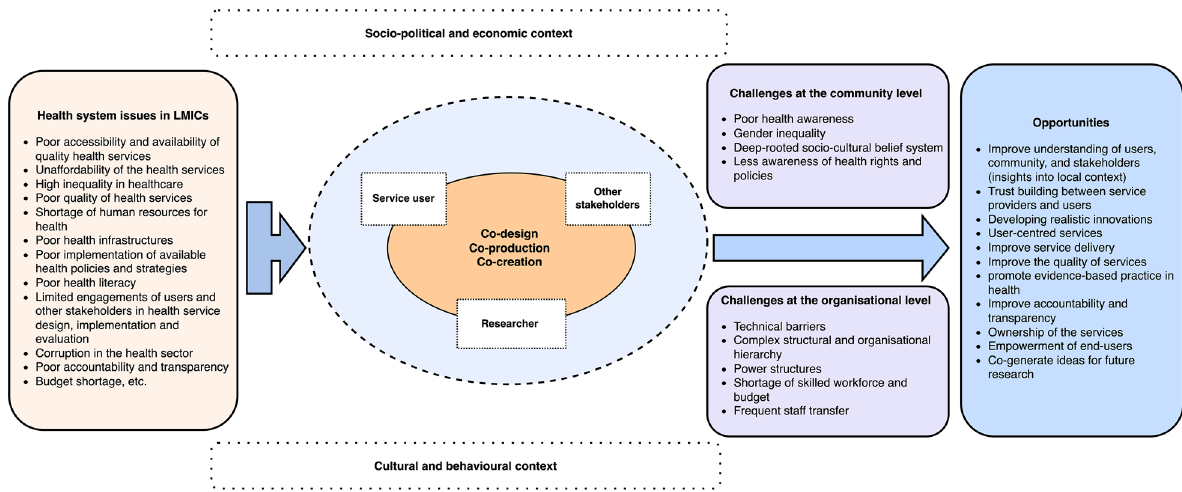
Fig. 1 Challenges and opportunities of co-design in the health services of LMICs, with consideration of